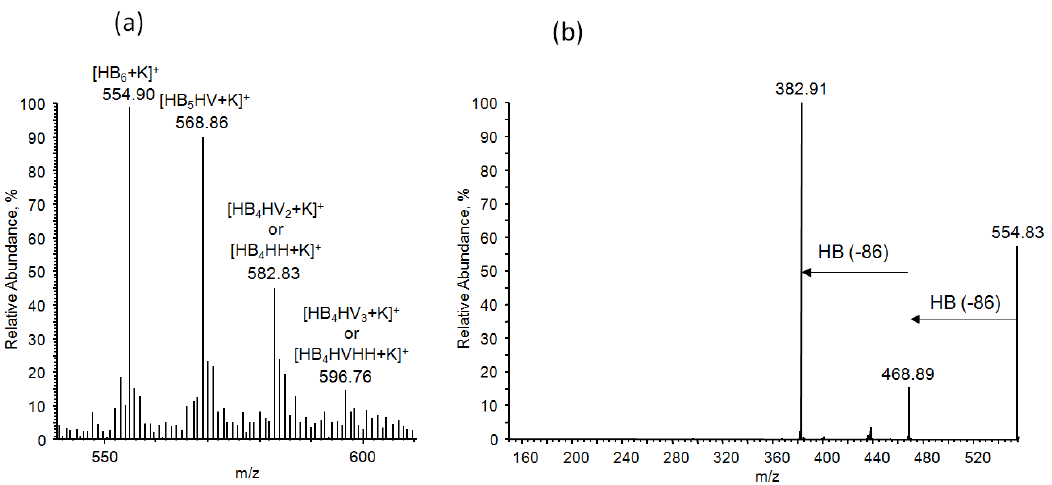
Figure 10. ( a ) The expanded spectral range at m/z 500 to 650 of the ESI-MS spectrum of low molar mass PHA oligomer; ( b ) the ESI-MS/MS spectrum of selected potassium adduct ions of oligomers [HB 6 + K] + at m/z 555.